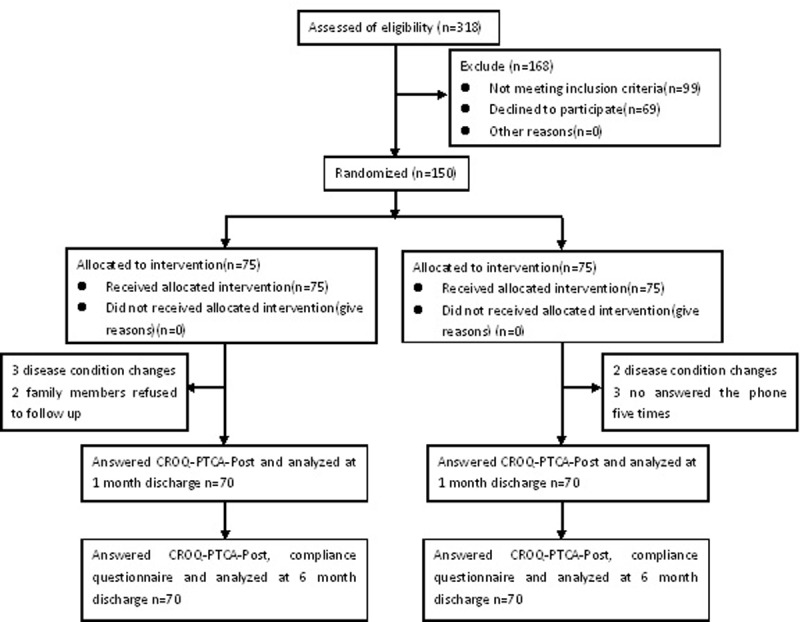
Consort diagram showing the flow of the entire study.